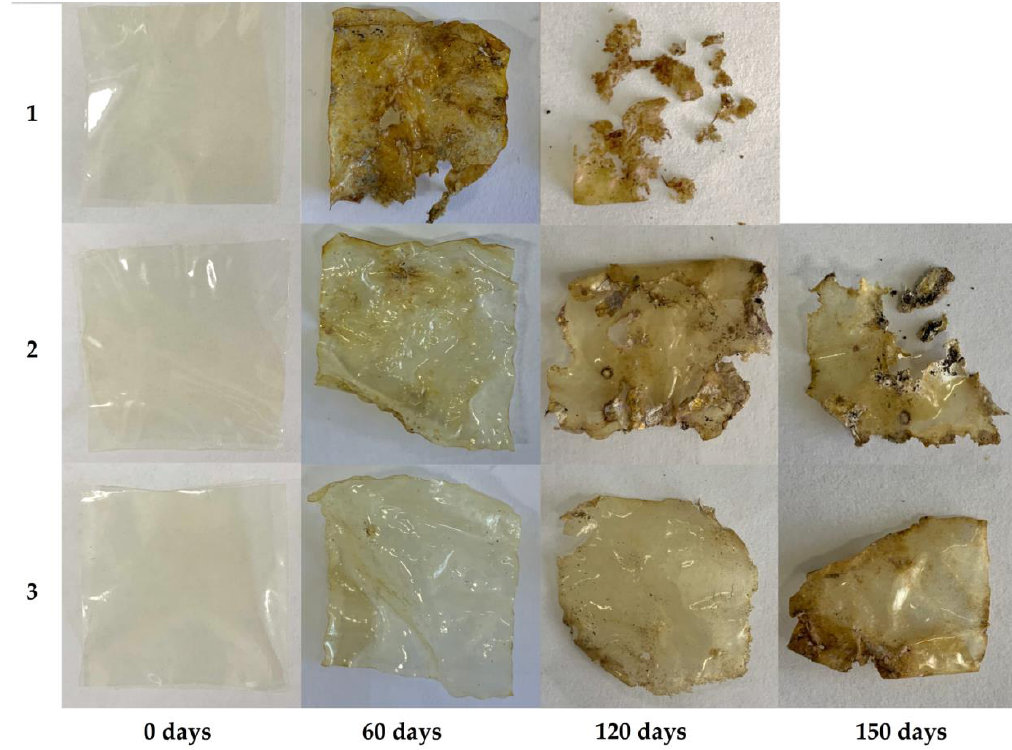
Figure 7. Chitosan films before and after soil degradation: 1-unmodified; 2-modified with poly(GMA-co-DMA); 3-modified with poly(GMA-co-LMA).